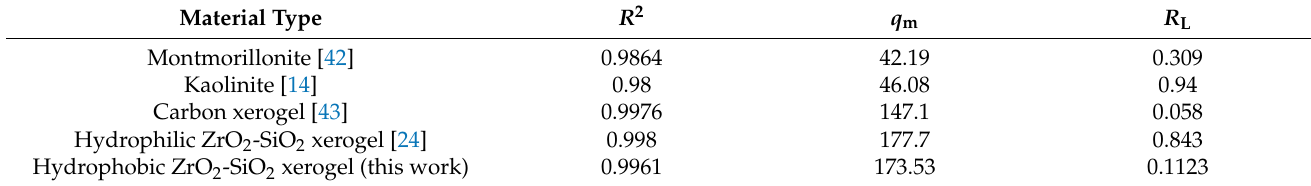
Table 4. Langmuir parameters of materials for RhB adsorption from various researchers.